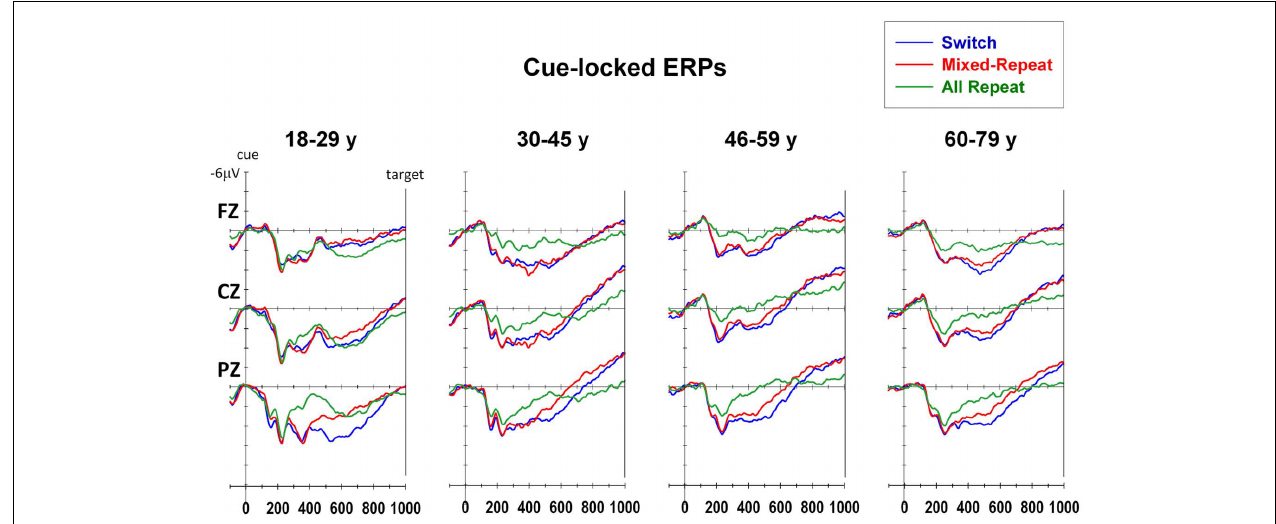
FIGURE 5 | Cue-locked event-related potentials for each trial type at midline electrodes.